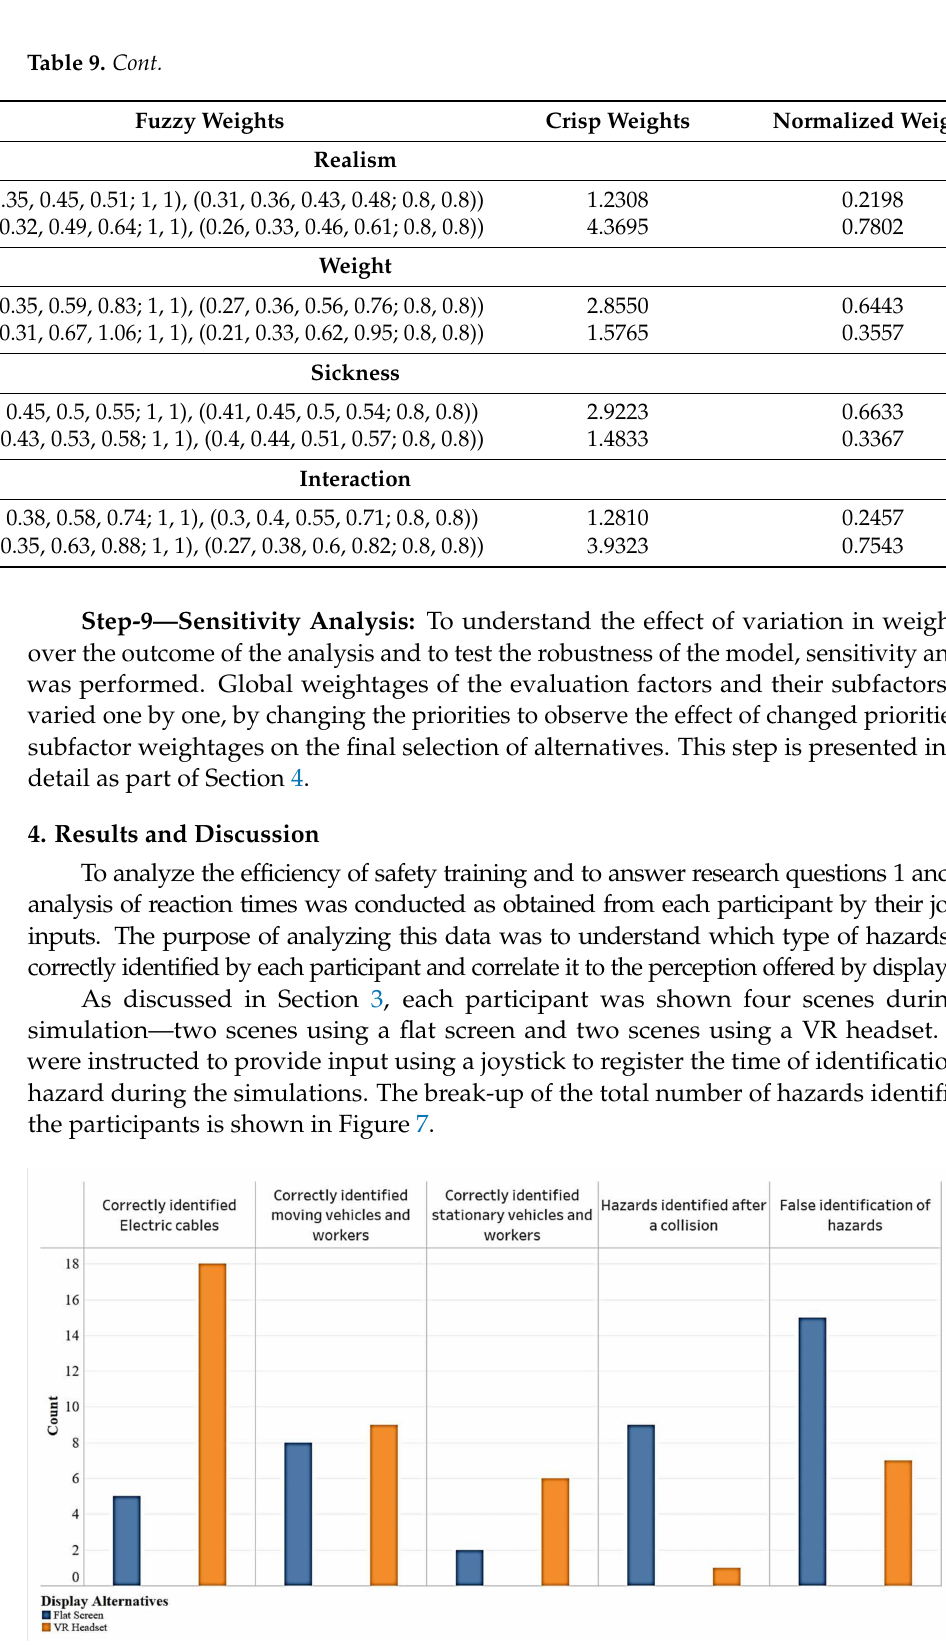
Figure 7. Hazard identification performance of